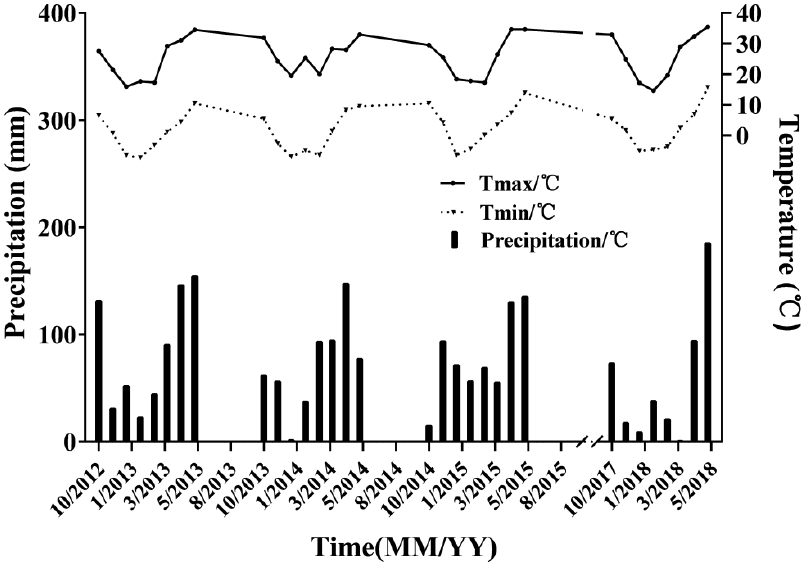
Figure 1. Monthly maximum and minimum temperature and precipitation in Wuhan during the four growing seasons. The solid and dashed lines represent the monthly maximum and minimum temperature, respectively, and the bar indicates the precipitation. Table 1. Datasets for model calibration (I–II) and evaluation (III–IV) of the model.